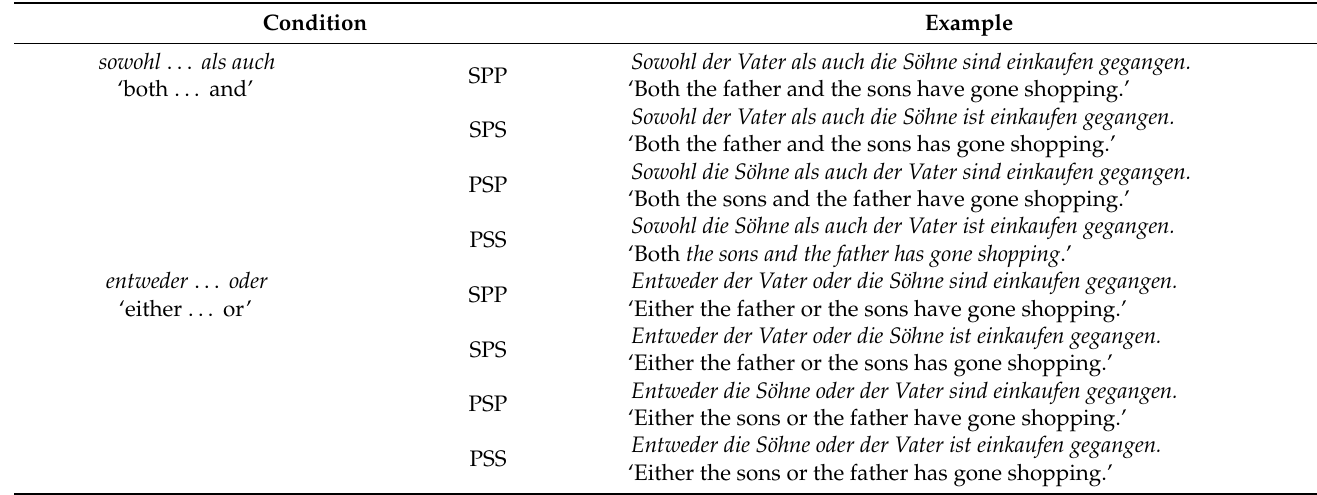
Table 8. Example stimulus set, Experiment 3 (S = singular, P =